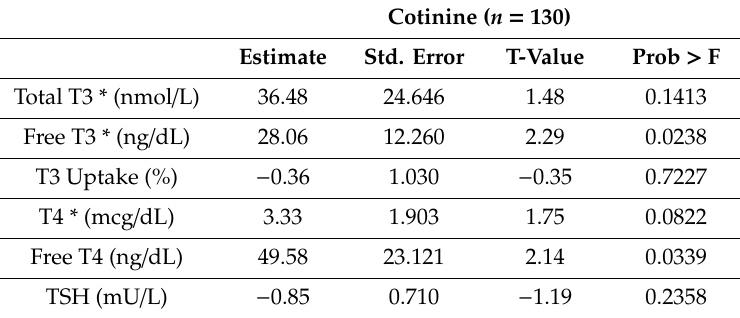
Table 9. Interaction of fetal thyroid hormone with